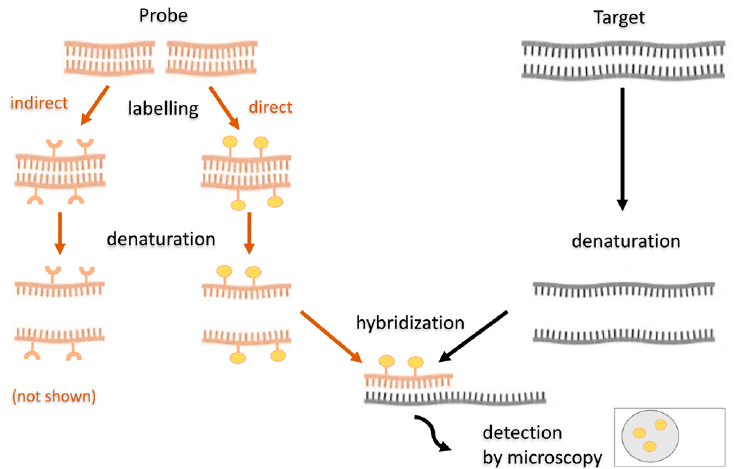
Figure 6. Scheme of the fluorescence in situ hybridization using a fluorescently (directly) labeled probe (modified from Speicher and Carter [116]).